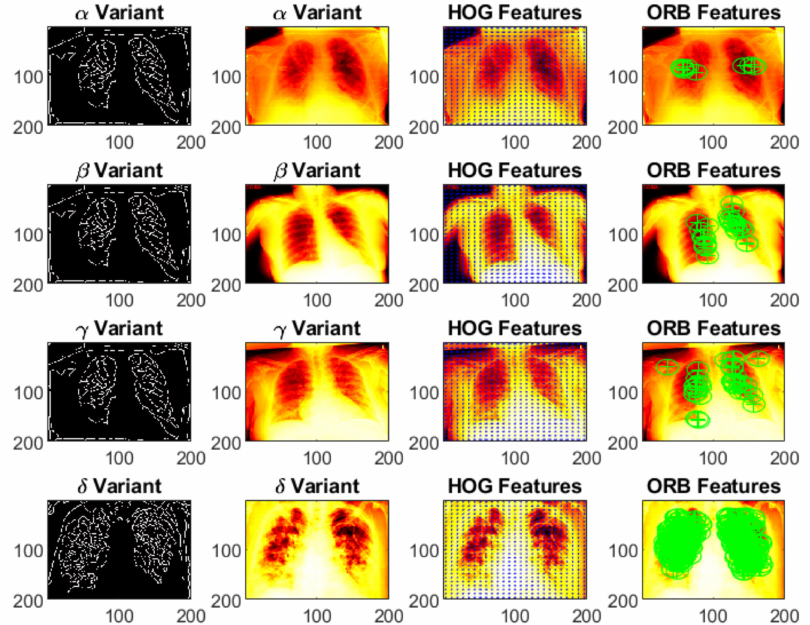
Figure 12. Comparison of the alpha, beta, gamma, and delta variants.